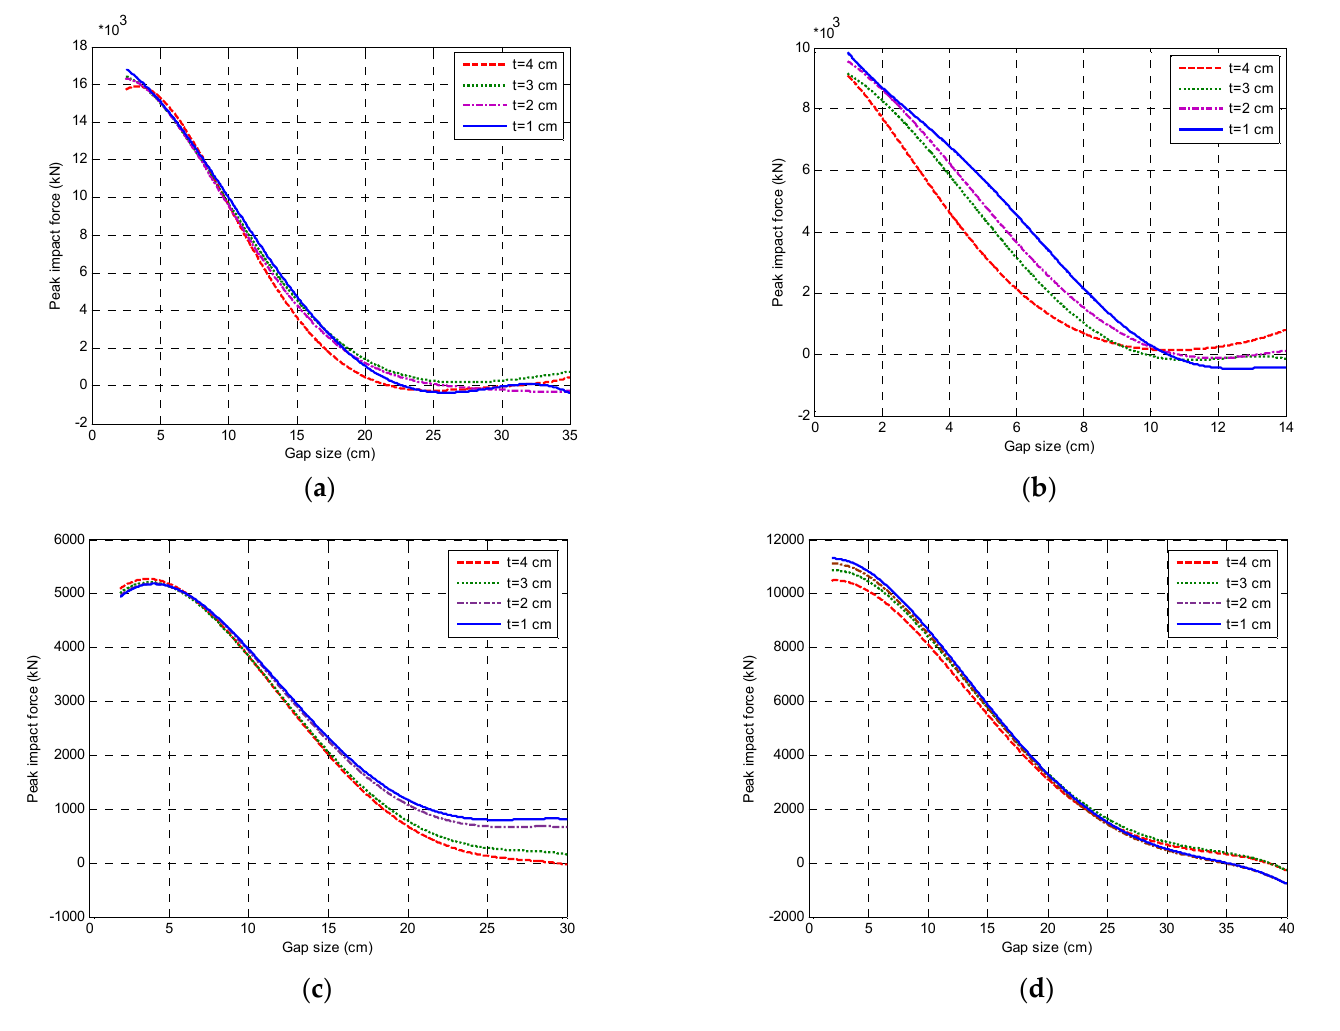
Figure 12. Peak values of impact force for different gap sizes and rubber bumper thicknesses under different seismic excitations: ( a ) Parkfield; ( b ) Kobe; ( c ) San Fernando; ( d ) Tabas.